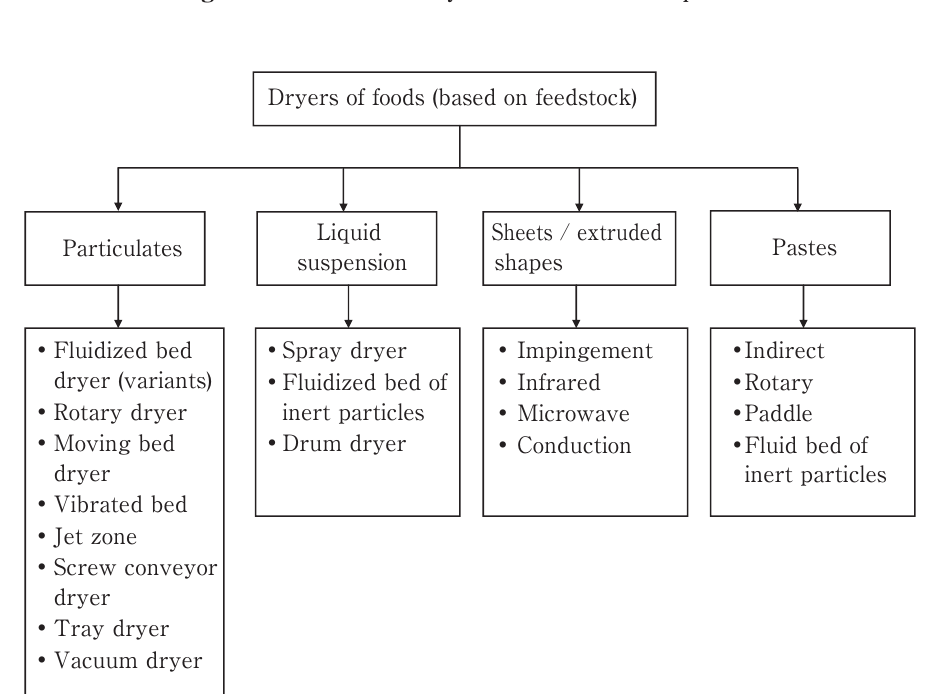
Fig. 1 Classification of dryers based on mode of operation.